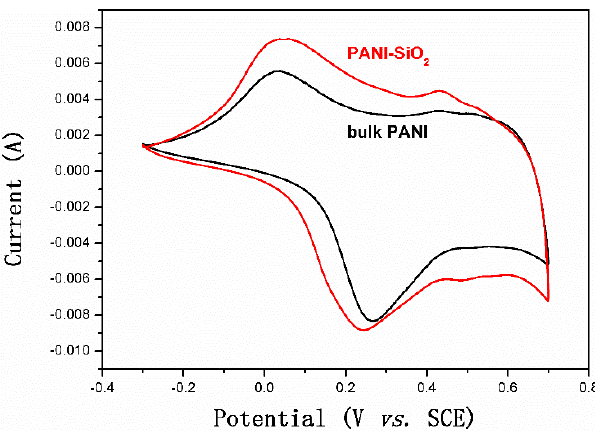
Figure 6. Cyclic voltammetry (CV) measurement results of bulk PANI and PANI-SiO 2 . SCE, saturated calomel